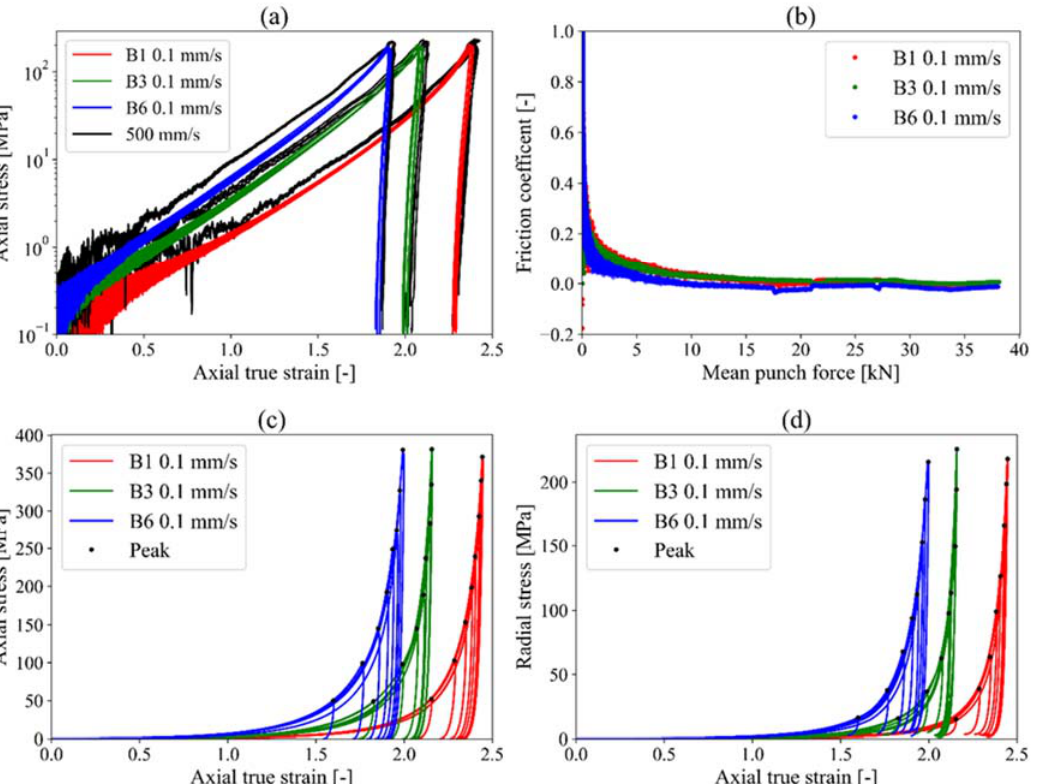
Figure 3. Experimental results of the instrumented die compression test of granules batches B1, B3 and B6. Strain rate dependency in logarithmic scale axial stress—axial true strain ( a ), friction coefficient—mean punch force ( b ), typical loading-unloading curves of granules compaction process indicating the influence of the sucrose content on axial stress—axial true strain ( c ) and radial stress— axial true strain ( d ) at 0.1 mm/s velocity.